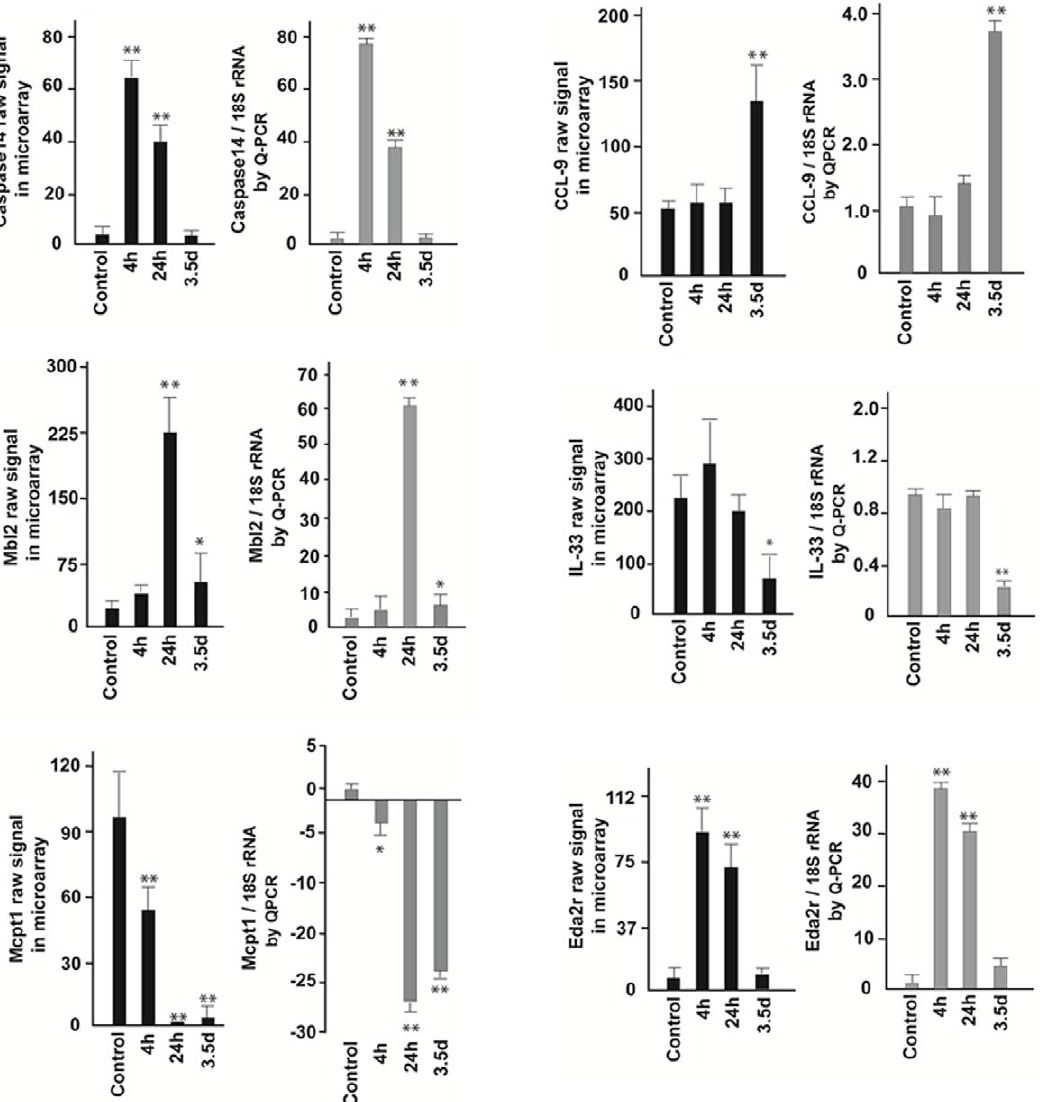
Figure 4. Validation of the selected genes in the whole gut by real-time RT-PCR. The left panels (black bars) demonstrate expression of the selected genes at different time points plotted by raw signals from the microarray. The right panels (gray bars) show the relative expression of the same selected genes normalized by 18S rRNA at different time points by real-time RT-PCR. The opposite direction of Mcpt1 demonstrates its down- regulation after